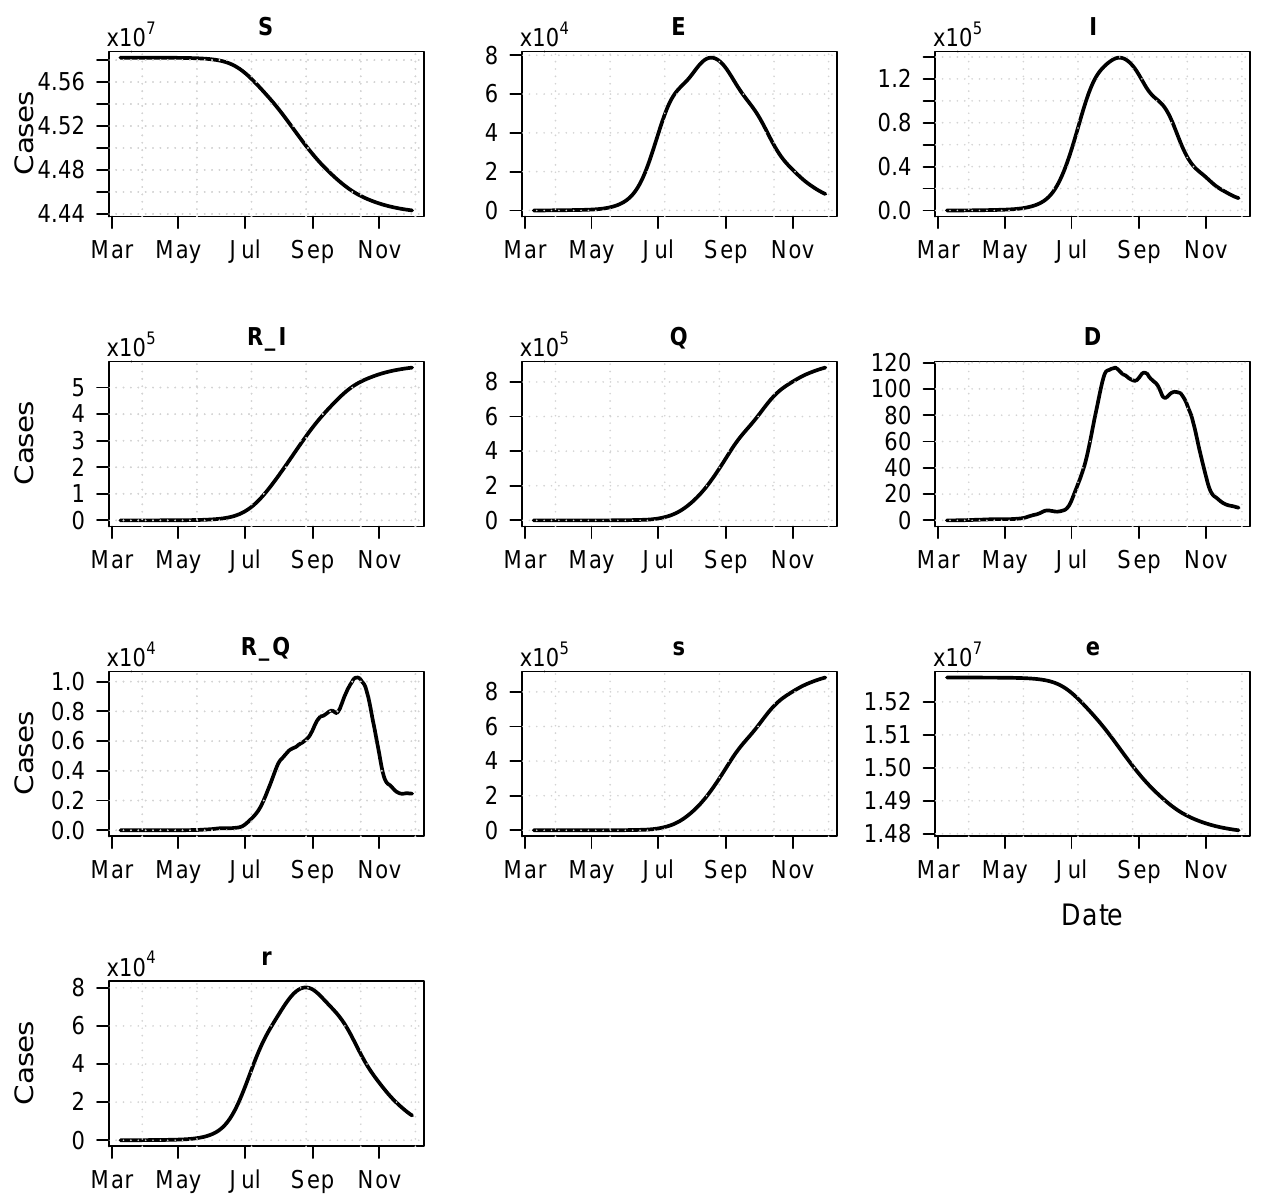
Figure 3. The posterior predictive mean of different infection stages from the SEIR model for